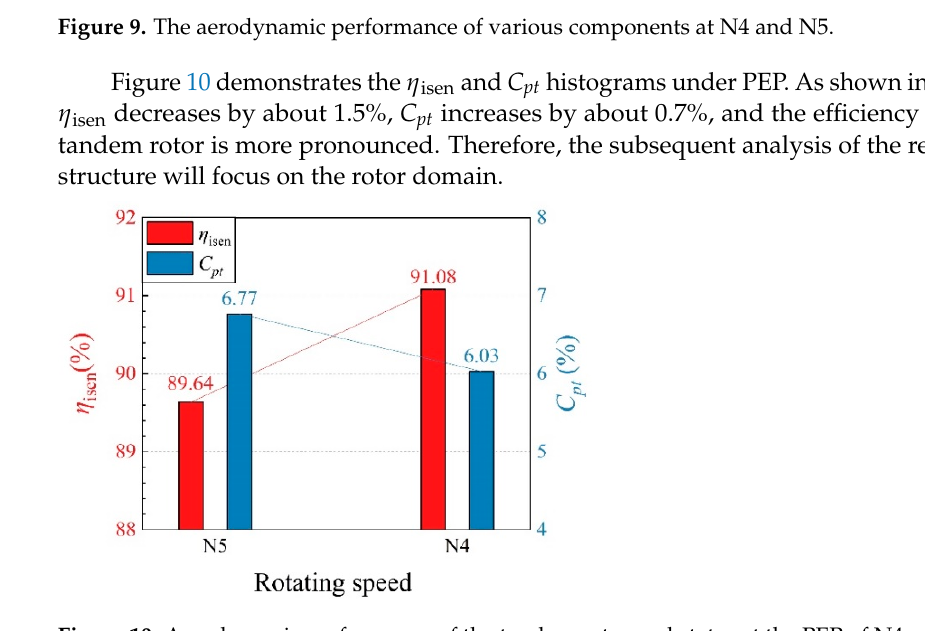
Figure 10. Aerodynamic performance of the tandem rotor and stator at the PEP of N4 and N5.